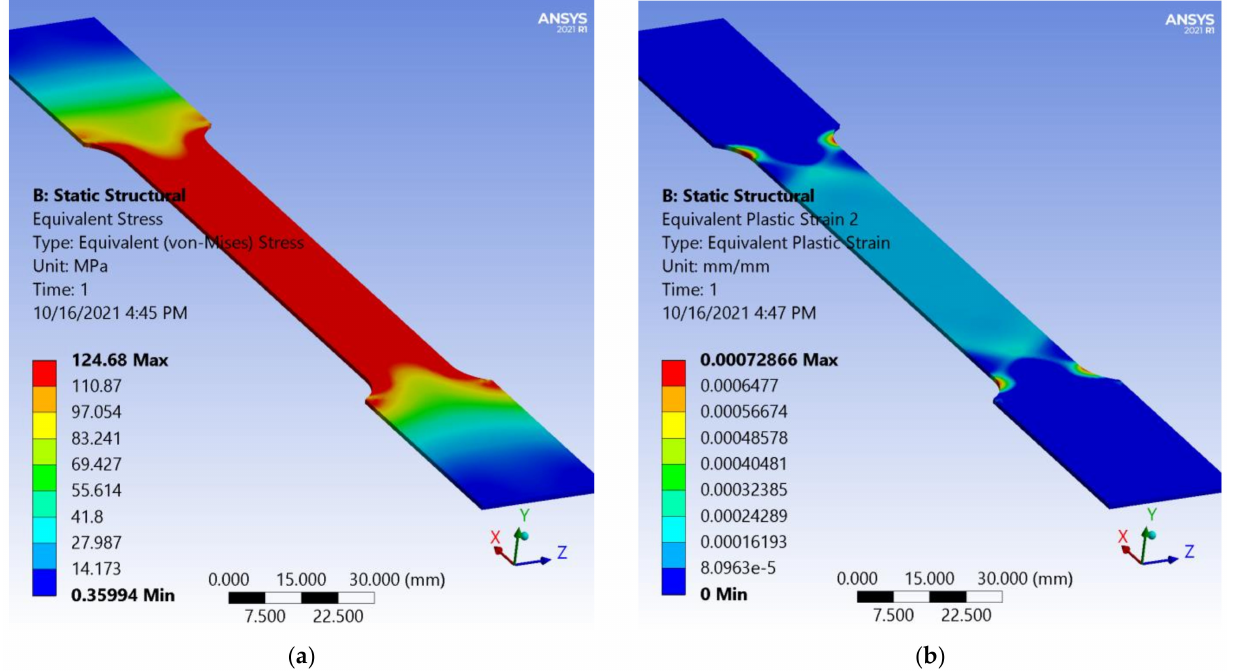
Figure 20. Results at 0.1 mm displacement: ( a ) equivalent von Mises stress; ( b ) equivalent plastic